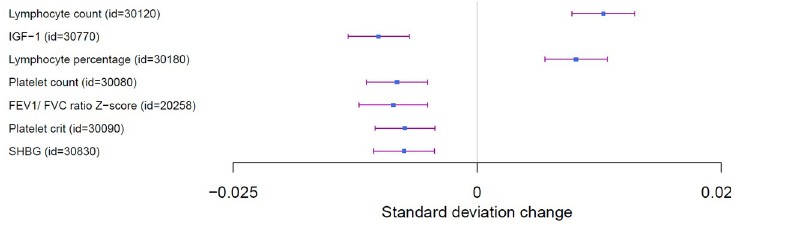
Fig 1. Forest plot of PheWAS analyses of severe COVID-19 risk.